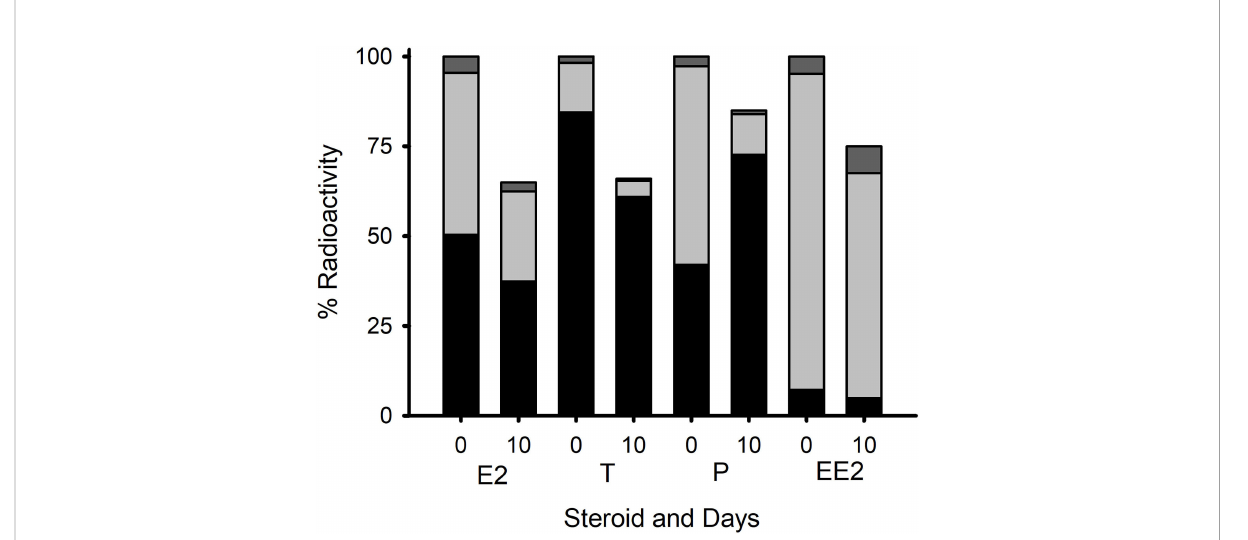
FIGURE 2 Radioactive residues of four steroids from L. stagnalis (whole tissue extracts) on day 0 (i.e. directly after the 8 h of exposure) and day 10 (i.e. after depuration) with day 0 being treated as 100%. The proportions of ester (black), free (light grey), and water-soluble (dark gray) that were found in the extracts on days 0 and 10 are also shown. Data are presented as mean percentage of the total radioactivity in each extract (n=5 for each time point, except for P, where n=4 on